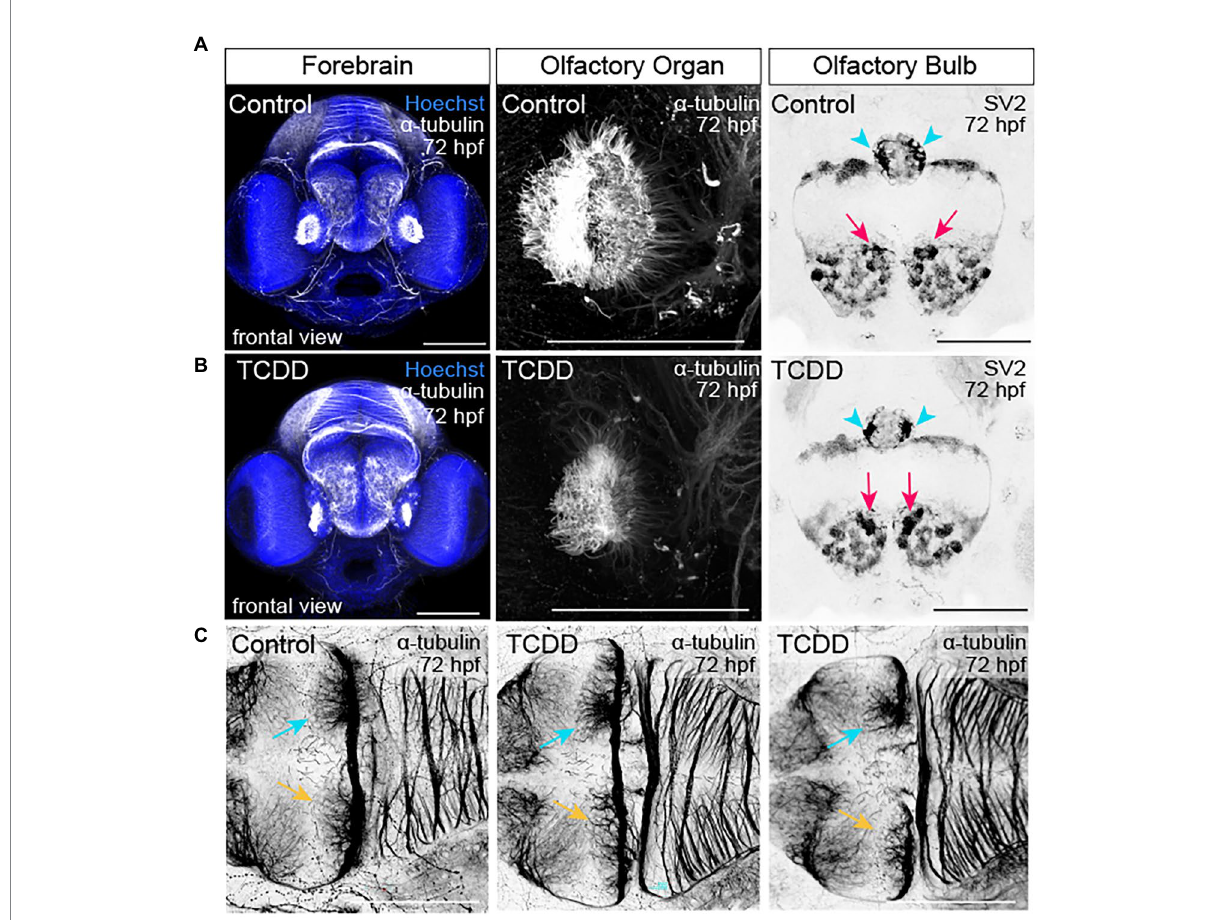
FIGURE 4 TCDD exposure disrupts development of the olfactory organs, olfactory bulbs, and habenular nuclei. (A,B) Frontal views of the embryonic forebrain at 72 hpf in control (A) and TCDD-exposed (B) larval zebrafish. Embryos were immunolabeled with an anti-acetylated α -tubulin antibody to visualize developing axon tracks (white and inverted to black) and stained with Hoechst (DNA, blue) to mark the parenchyma. Glomeruli in the olfactory bulb were visualized using anti-synaptic vesicles 2. TCDD exposure disrupted development of both the olfactory organs and the glomeruli in the olfactory bulbs. Pink arrows indicate the medial glomerular clusters in the olfactory organs. Mitral cells in medial glomerular clusters make asymmetric, direct projections to the right habenular nuclei (aqua arrows, yellow arrows indicate the left nuclei). (C) Development of the habenular nuclei was impaired at 48 hpf (see Supplementary Figure 4) and abnormal in all larvae scored at 72 hpf. Two examples of the habenular phenotypes are shown in C. Olfactory organ: n = 10 fish/group across 3 replicates. Olfactory bulb: n = 7–10 fish/group across 2 replicates. Habenula: n = 7–10 fish/group across 2 replicates. The dorsal surface of the brain is at the top and the ventral surface is at the bottom in (A,B) . Anterior is at the top in (C) . Scale bar = 100 μ